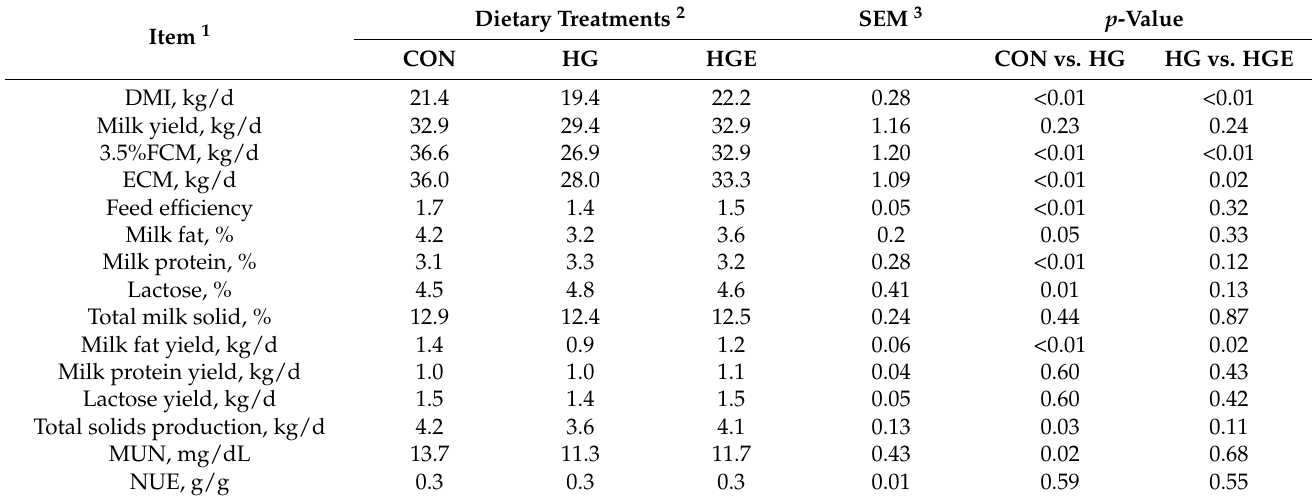
Table 2. Effects of vitamin E on the performance of subacute ruminal acidosis cows.